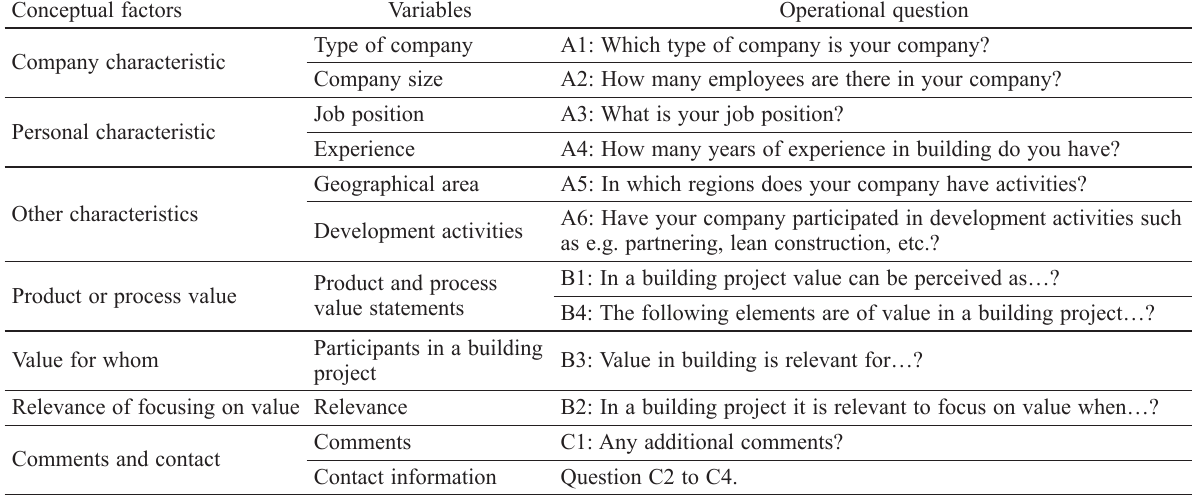
Table 1. Scope of